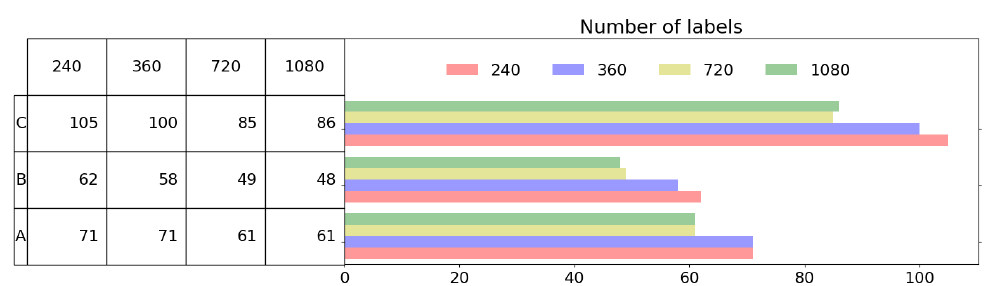
Figure 5. Number of labels obtained at different video resolutions for